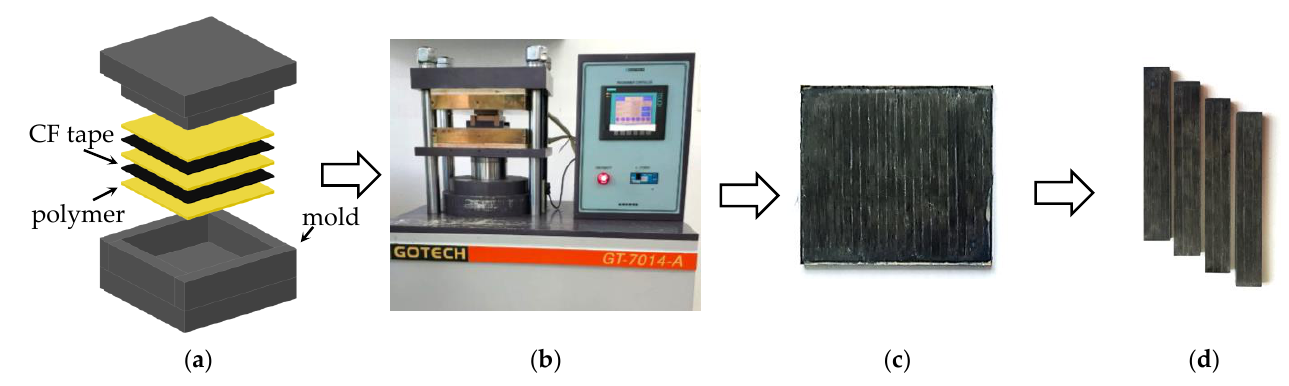
Figure 2. The step-by-step diagram of the process of fabricating laminated composite samples: stacking layers ( a ); hot compressing ( b ); plates (blanks) for cutting specimens for the mechanical tests ( c ); ready specimens ( d ).